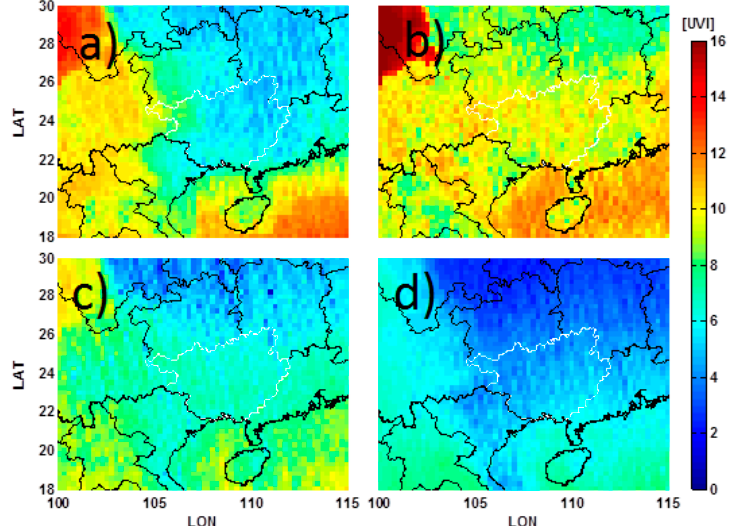
Figure 11. UV index distribution in 2014 based on OMI. ( a ) April; (b) July; ( c ) October; ( d ) January.